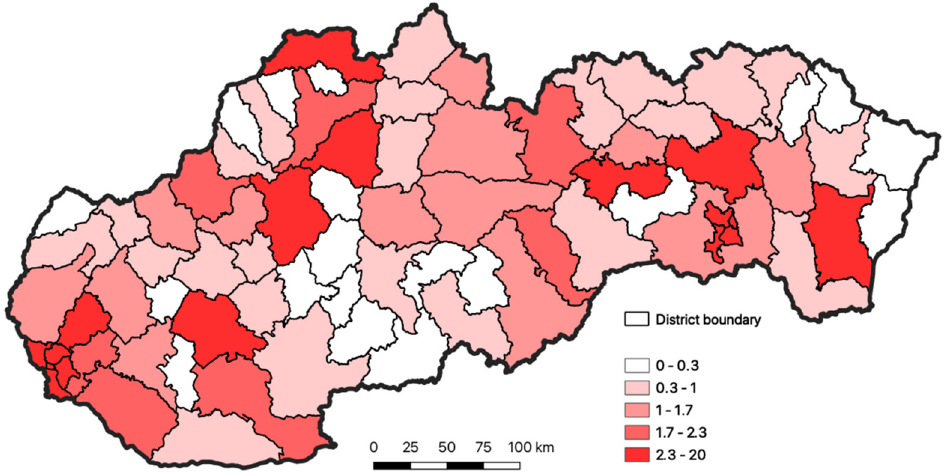
Figure 1. Occurrence of COVID ‐ 19 disease in the individual districts of Slovakia for the period